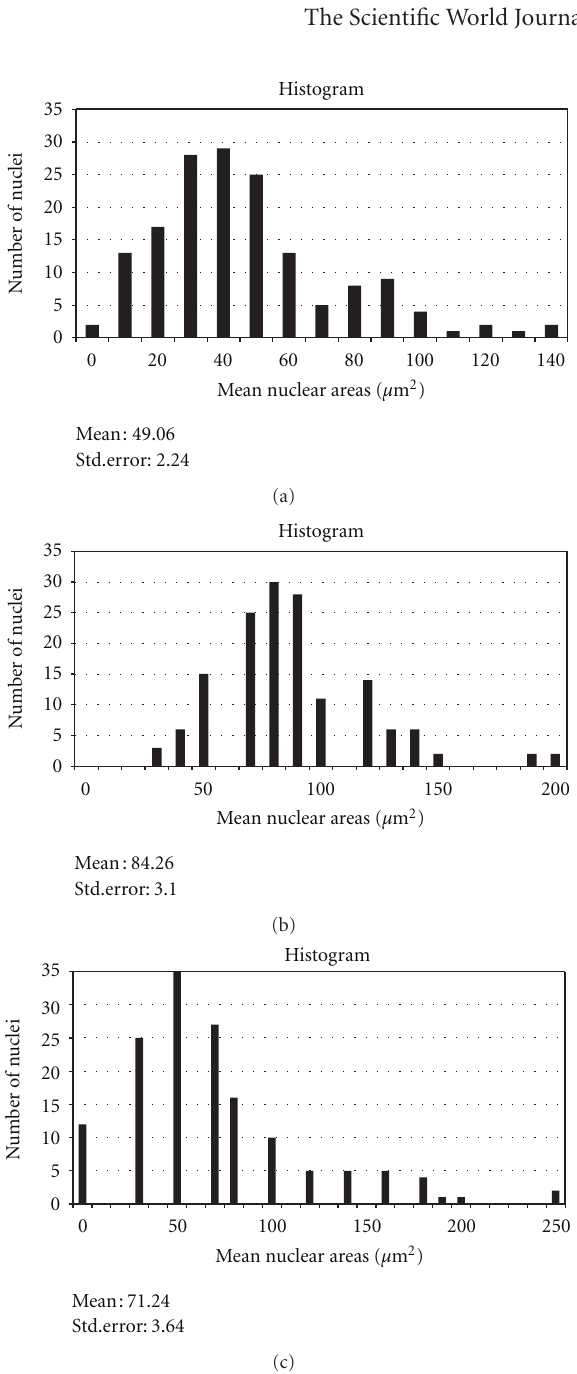
Figure 2: (a) Mean nuclear areas for in vivo primary root cells. (b) Mean nuclear areas for in vitro primary root cells (normal). (c) Mean nuclear areas for in vitro primary root cells (abnormal)